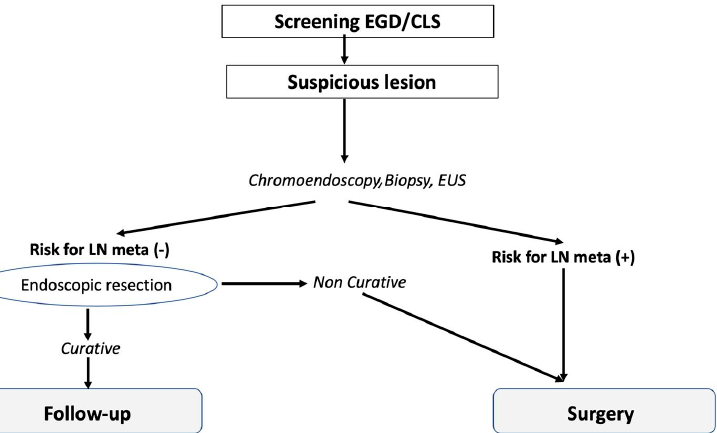
Figure 1. Diagnostic flowchart for patients with suspected superficial GI cancer to select those eligible for ESD or surgery. (LN—lymph node; CLS—colonoscopy). For each patient, a histopathological diagnosis was obtained before ESD or surgical treatment. All data from patients who were diagnosed with histology ‐ confirmed gastrointestinal adenocarcinoma or epithelial dysplasia were registered in a database. Patient identifiers were removed to allow analysis without violating sensible patient